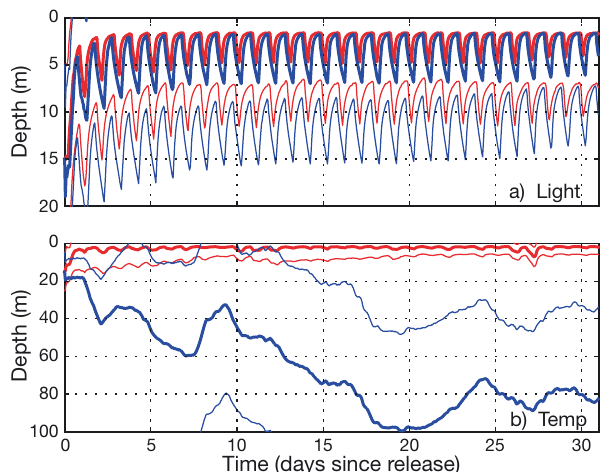
Fig. 8. Median depth (thick lines) ± 1 SD (thin lines) during the nauplii stages in (a) light- and (b) temperature-controlled simulated Lepeophtheirus salmonis during the simulation periods March (blue lines) and May (red lines) 2009 based